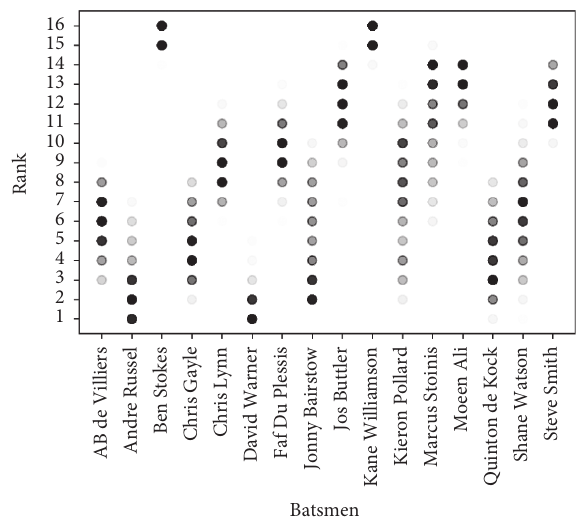
Figure 5: Heat map for batsmen ranks generated by NR-TOPSIS.